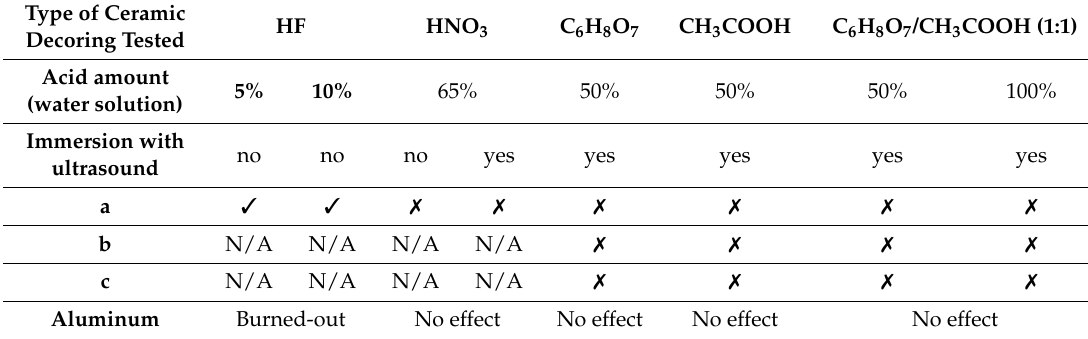
Table 7. Ceramic decoring effectiveness ( (cid:51) ) or ineffectiveness ( (cid:55) ). Type of Ceramic